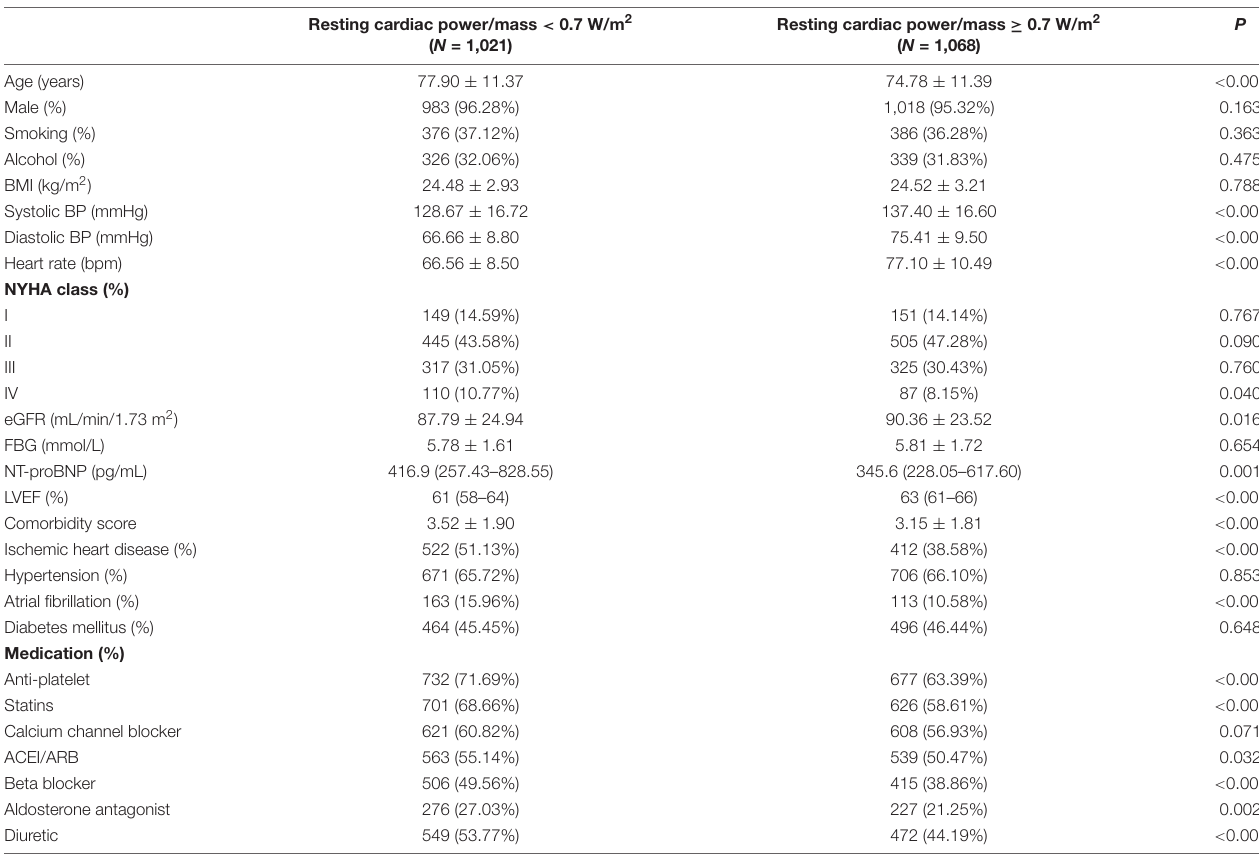
TABLE 1 | Baseline characteristics of patients with